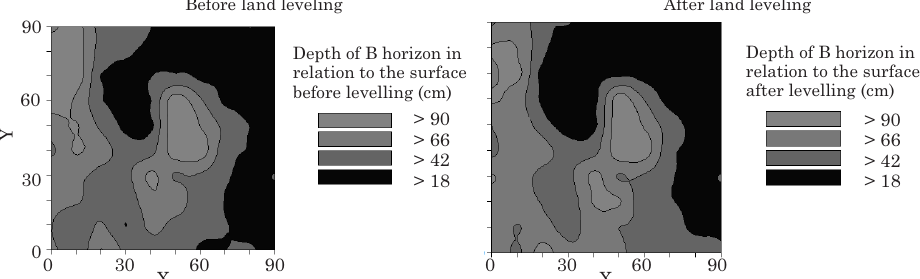
Figure 7. Maps of the spatial distribution of the distance to the top of the B horizon in relation to the soil surface before (left side) and after (right side) land leveling.